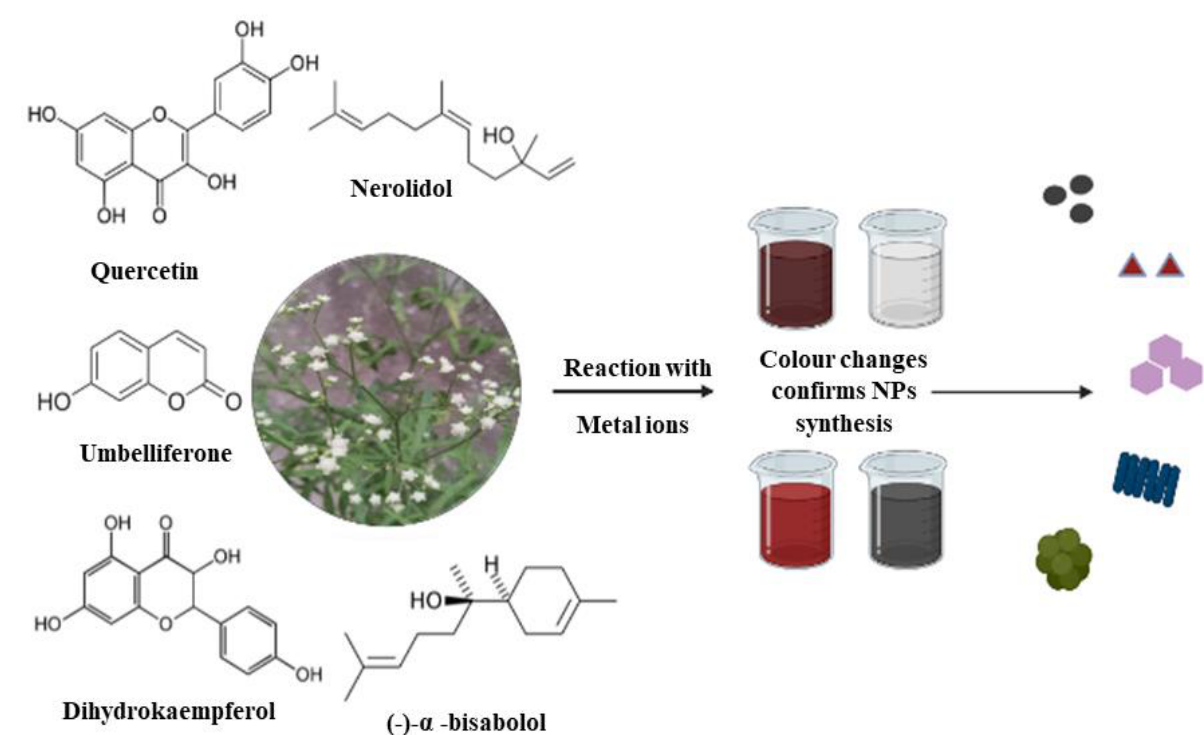
Figure 2. Summary of the role of phytochemicals present in Asteraceae family in reduction of metal ions to various nanostructured materials.